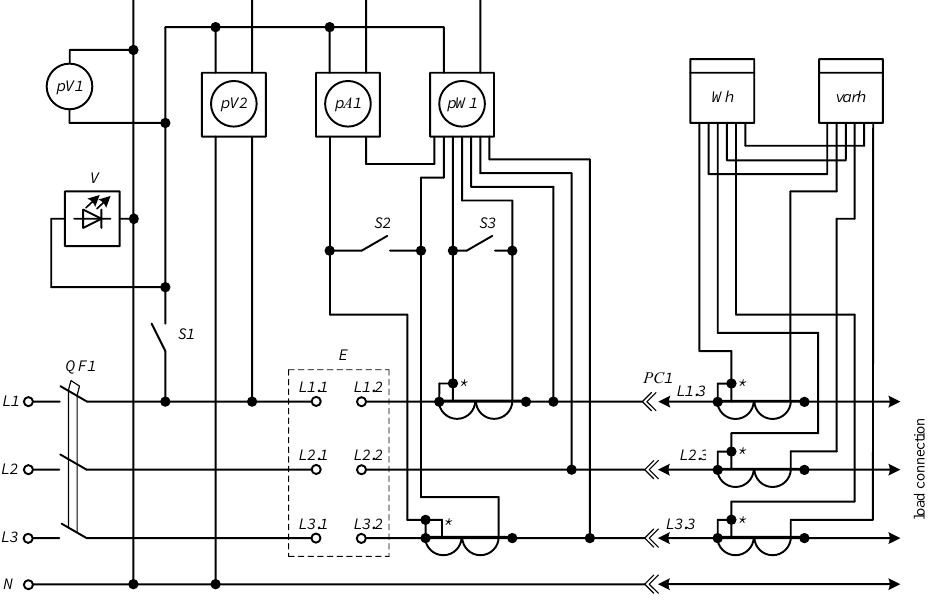
Figure 1. Schematic circuit diagram of the measuring stand: * — generator clamp (connects to power supply).